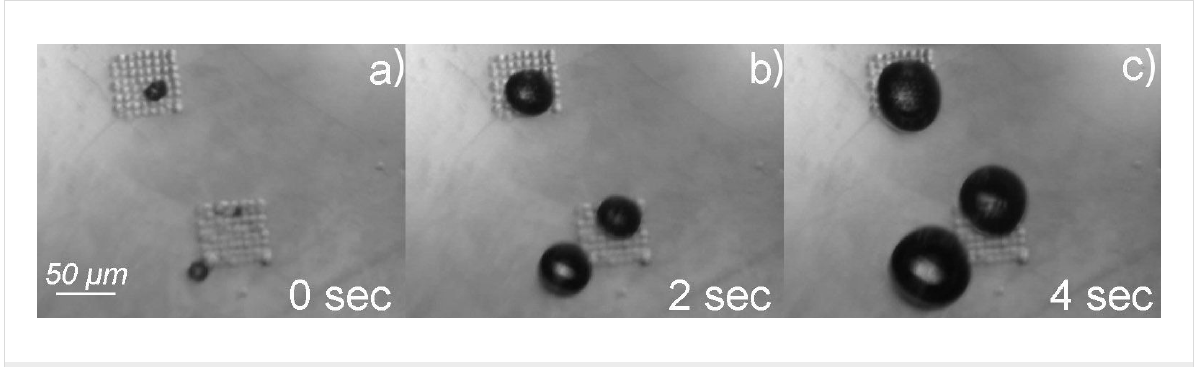
Figure 3: H 2 O 2 decomposition reaction catalyzed by FeCl 3 . The process was recorded by the optical microscope under 30% H 2 O 2 solution. The FeCl 3 [Bmim]Cl solution assembled on two 8 × 8 OTSpd disc arrays. The IL drops were protected by a layer of OTS film coating. a), b), c): The same region with two OTS-coated IL arrays were immersed under 30% H 2 O 2 solution and recorded at 0, 2, and 4 seconds, respectively. The